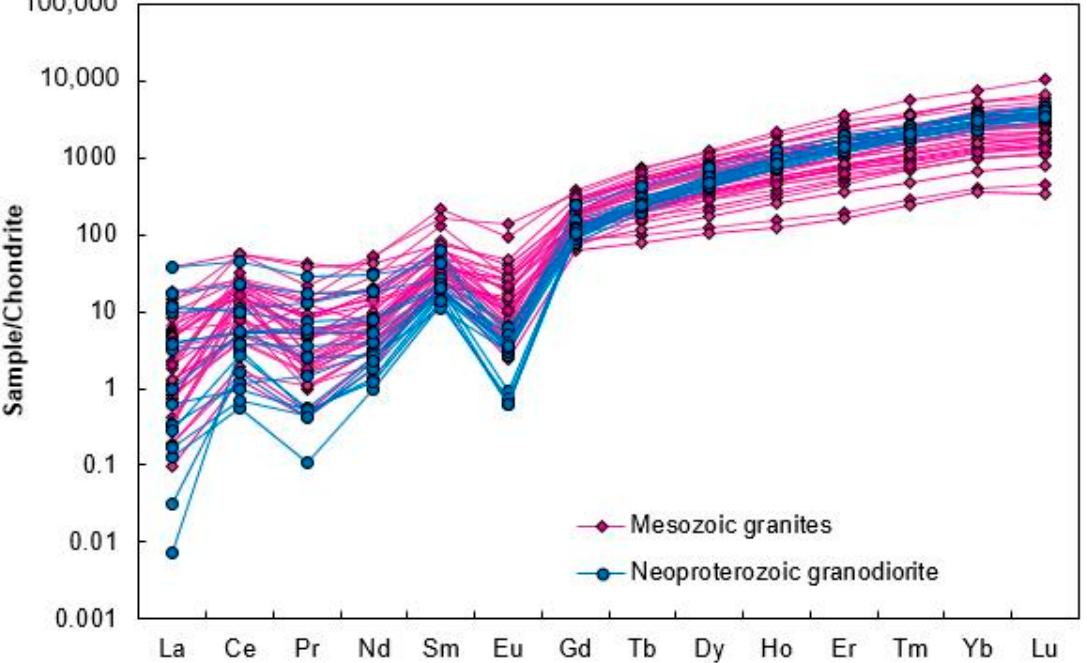
Figure 10. Chondrite-normalized zircon REE patterns of the Shimensi granodiorite. Chondrite normalization values are from Sun and McDonough [41]. Data of the ore-related Mesozoic Shimensi granites are from Wei et al. [6].